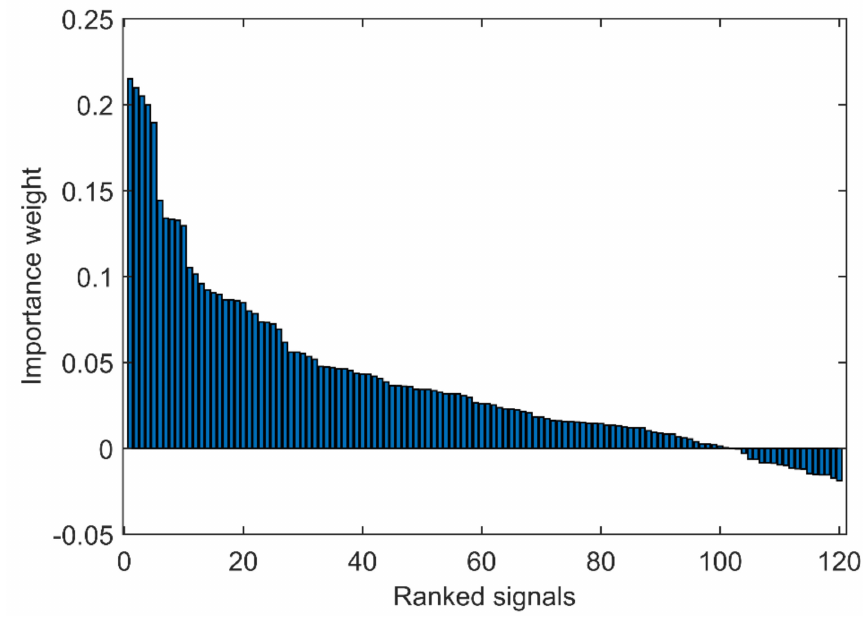
Figure 5. Relief weights and ranking for the features of the modified poker8vs6